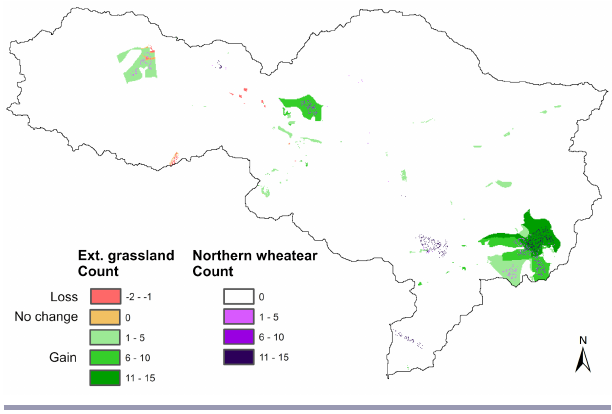
Fig. 9. Gain and loss of extensive grassland patches compared to the status quo and prediction of suitable habitat for the Northern Wheatear across the 15 best solutions for willingness to pay function 2. Red = loss of extensive grassland; orange = no change; green = gain in extensive grassland. Purple dots = suitable habitat for Northern Wheatear. Counts associated with colors indicate the number of times out of 15 that the patch was affected (grassland) or how often the bird was predicted at that spot (Northern